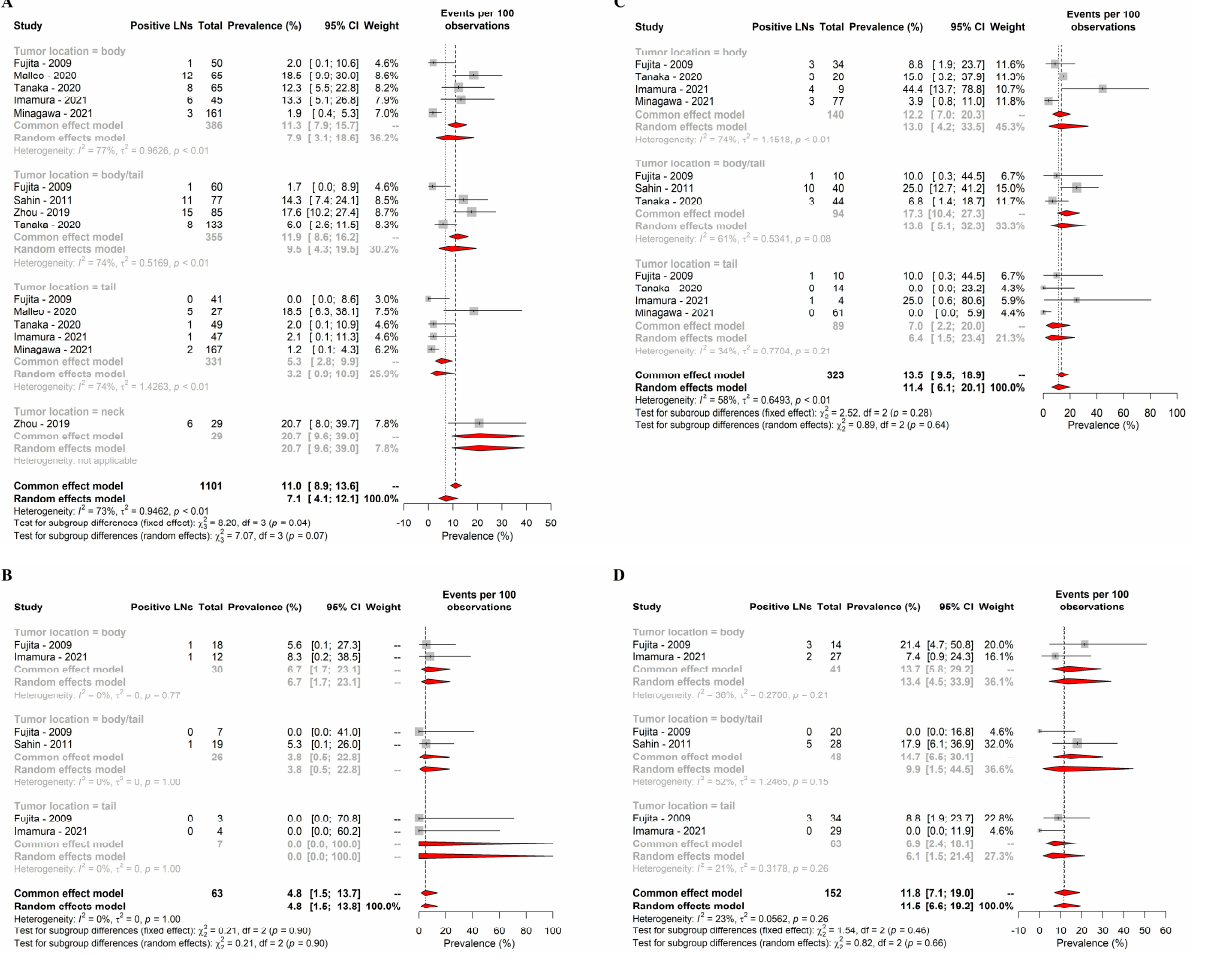
Figure 3. Meta-analysis of proportions: prevalence of nodal metastases to ( A ) stations 8–9; ( B ) station 12; ( C ) stations 14–15; ( D ) station 16.